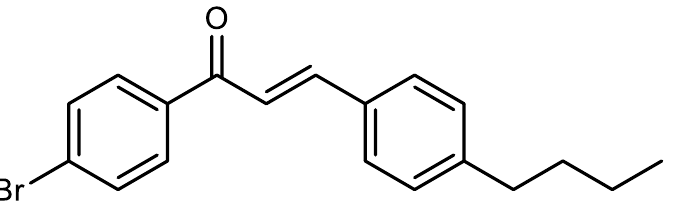
Figure 1. Molecular structure of 3-(4-butylphenyl)-1-(4-bromophenyl)-prop-2-en-1-one